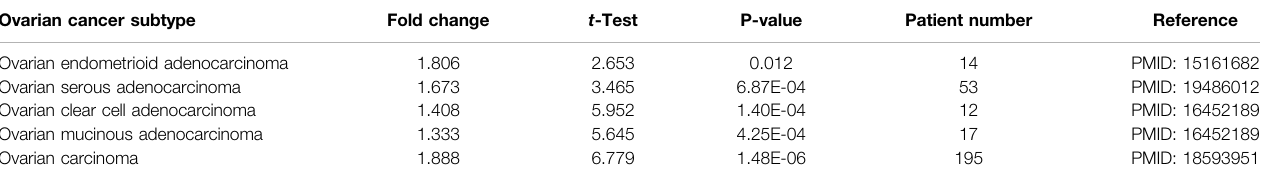
TABLE 1 | CMTM6 expression in diverse subtypes of OV and normal tissues using the Oncomine database. Ovarian cancer